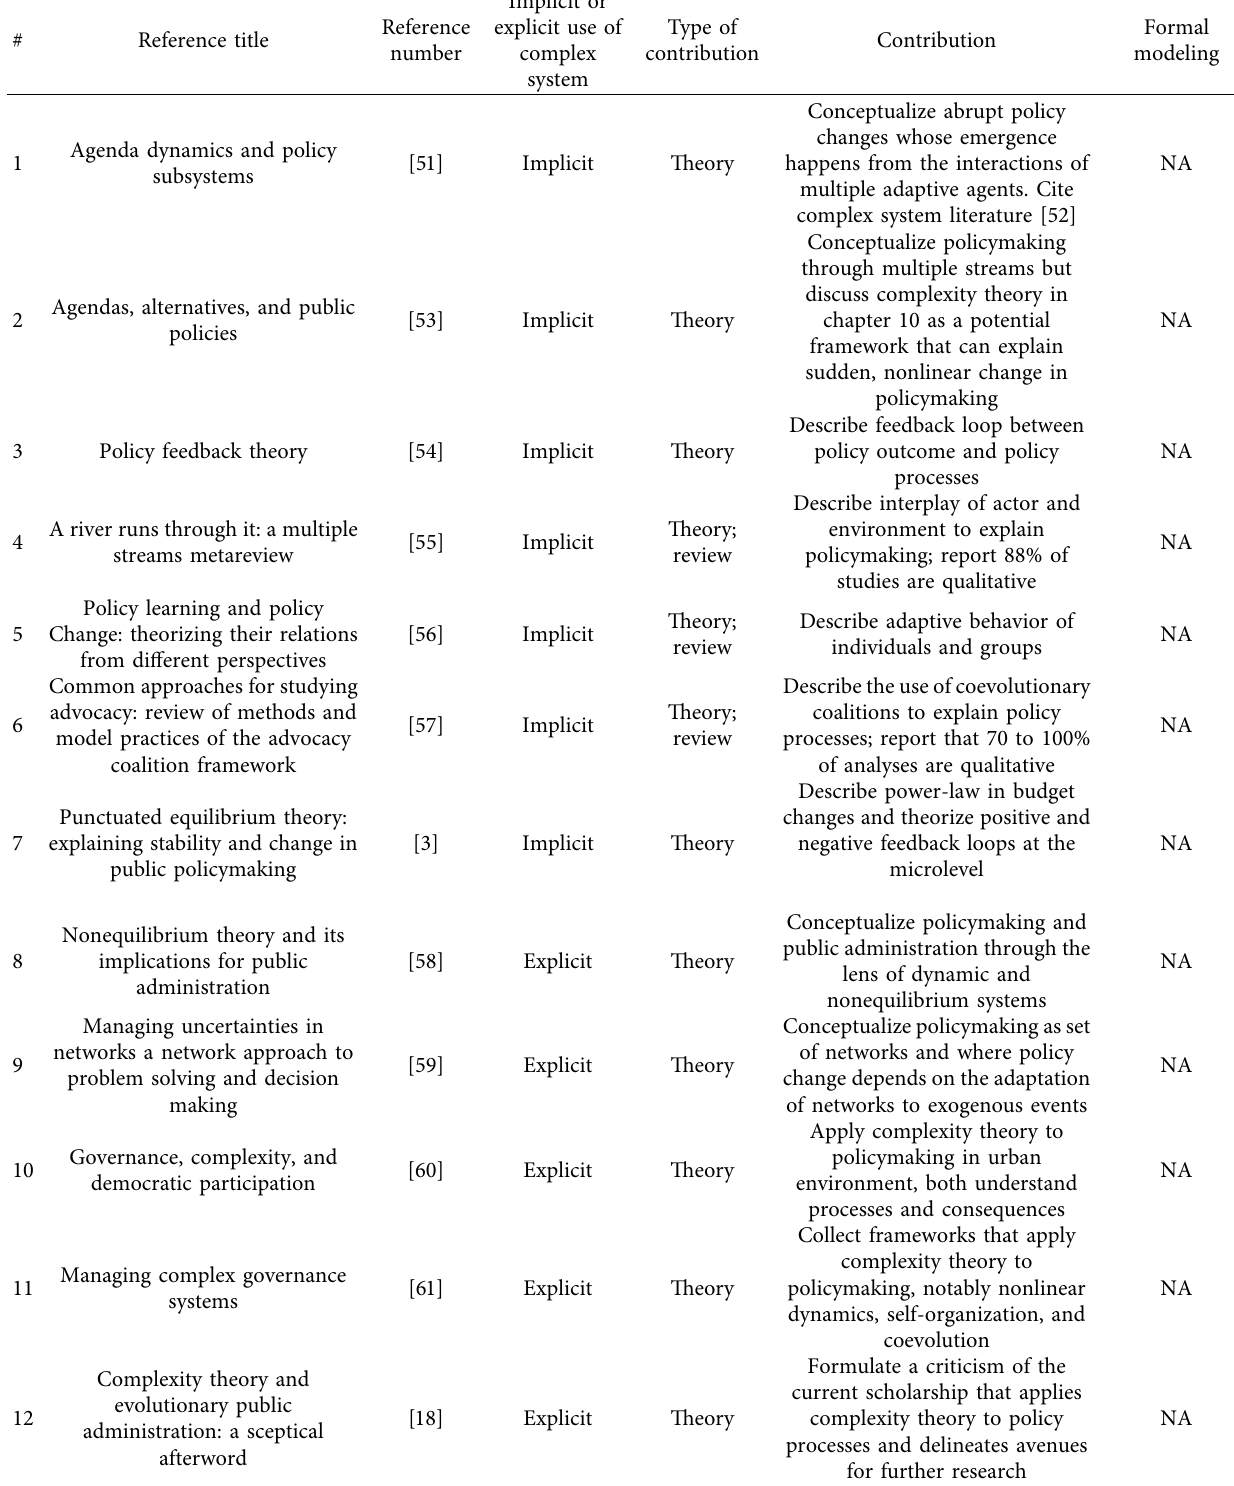
Table 1: Literature applying complexity science to the study of policy processes. Stream 1 (1–7) applies complexity science implicitly and conceptually. Stream 2 (8–26) applies complexity science explicitly and conceptually. Stream 3 (27–41) applies complexity science together with formal